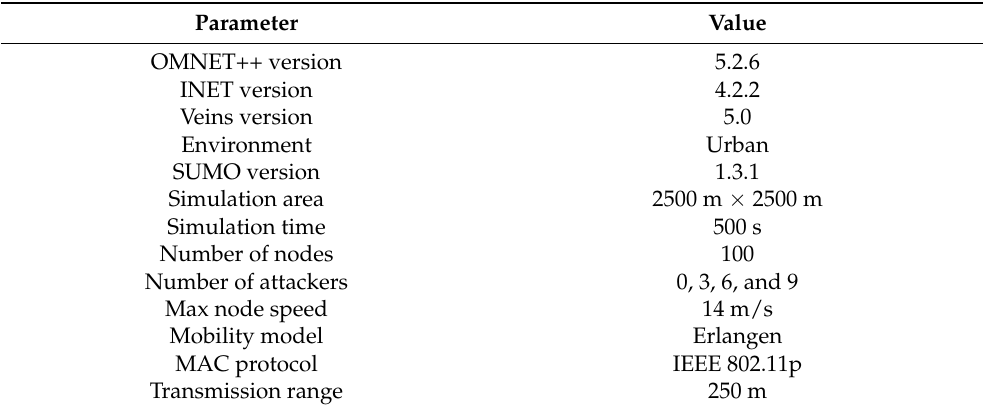
Table 4. Simulation parameters.